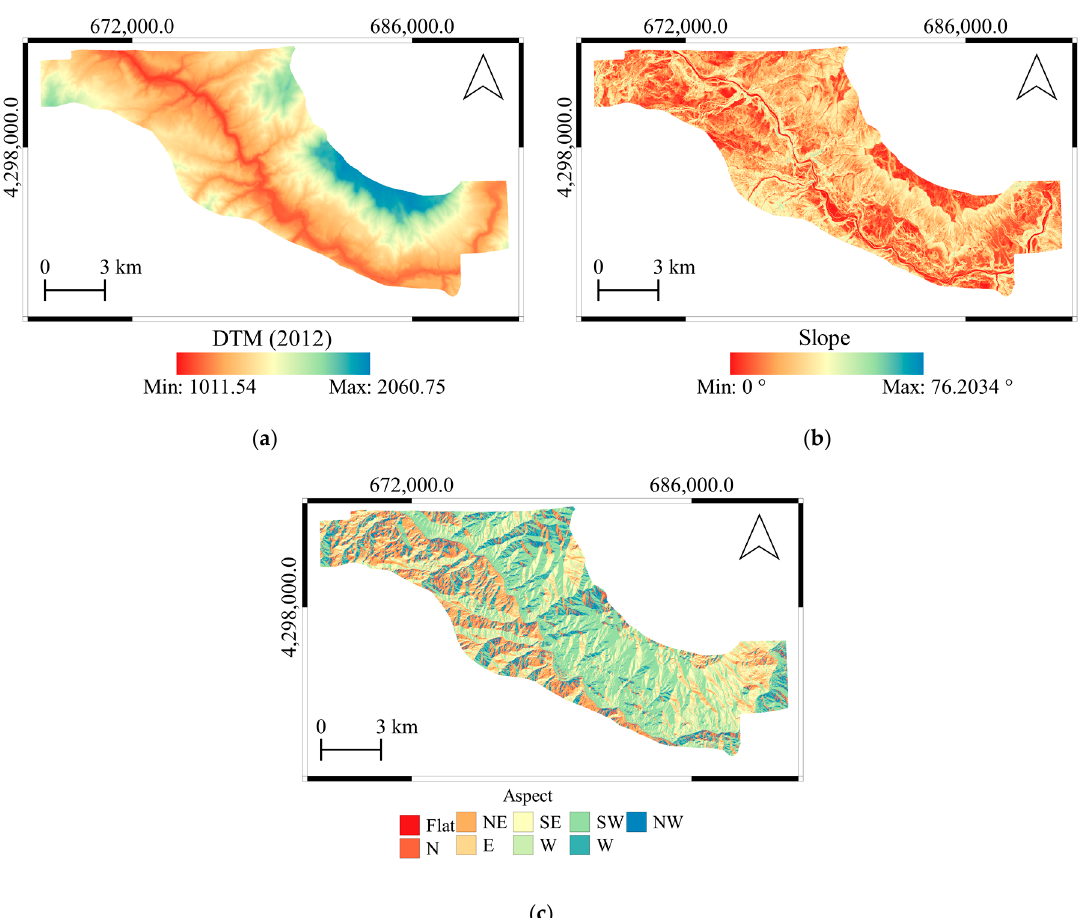
Figure 4. Spatial distribution of ( a ) altitude in meters, ( b ) slope in degrees, and ( c ) aspect as geographical directions. The parameters have been calculated from the DTM of year 2012.